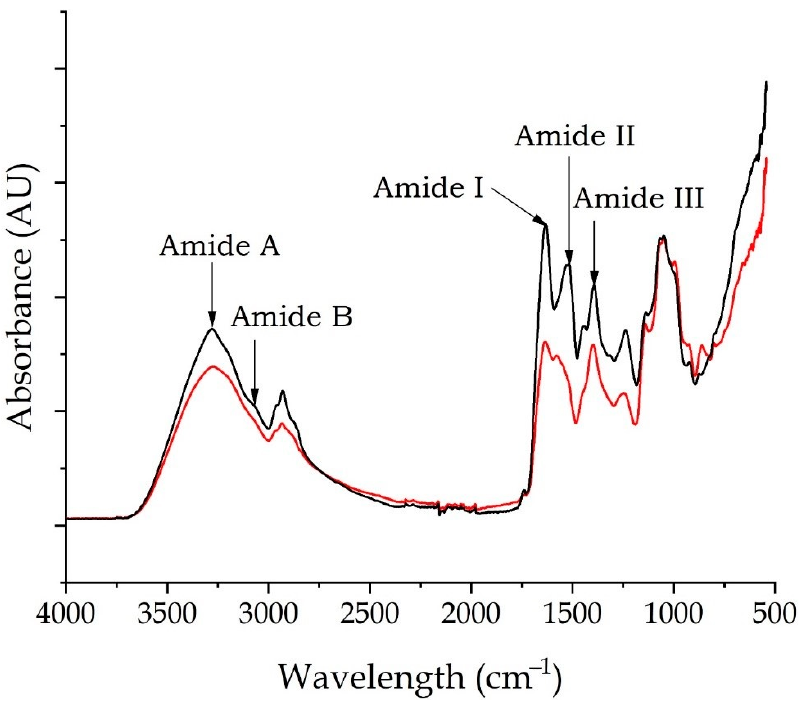
Figure 3. FTIR spectra of PPI (black line) and SPPH (red line), expressed as absorbance (AU) over wavelength (cm ⁻ 1 ).